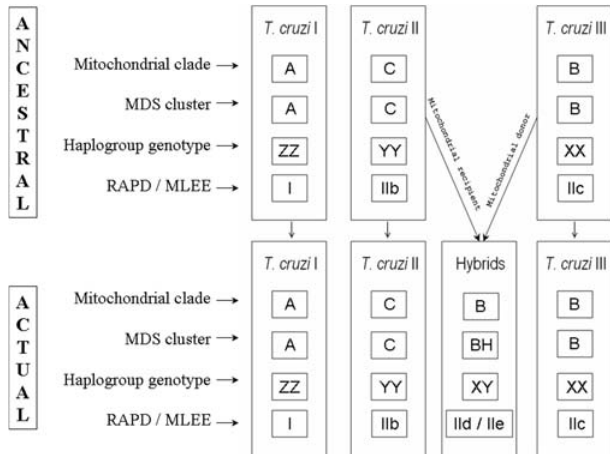
Figure 5. Diagram Depicting the Proposed Model for the Evolution of T. cruzi Strains The mitochondrial clade was typed by RFLP of the COII maxicircle gene, the MDS clusters were established by multidimensional scaling of microsatellite data, the haplogroups were established by haplotype estimation from multilocal genotypes followed by median joining network analysis, and the RAPD/multilocus enzyme electrophoresis typing was obtained from Brisse et al. [26]. DOI: